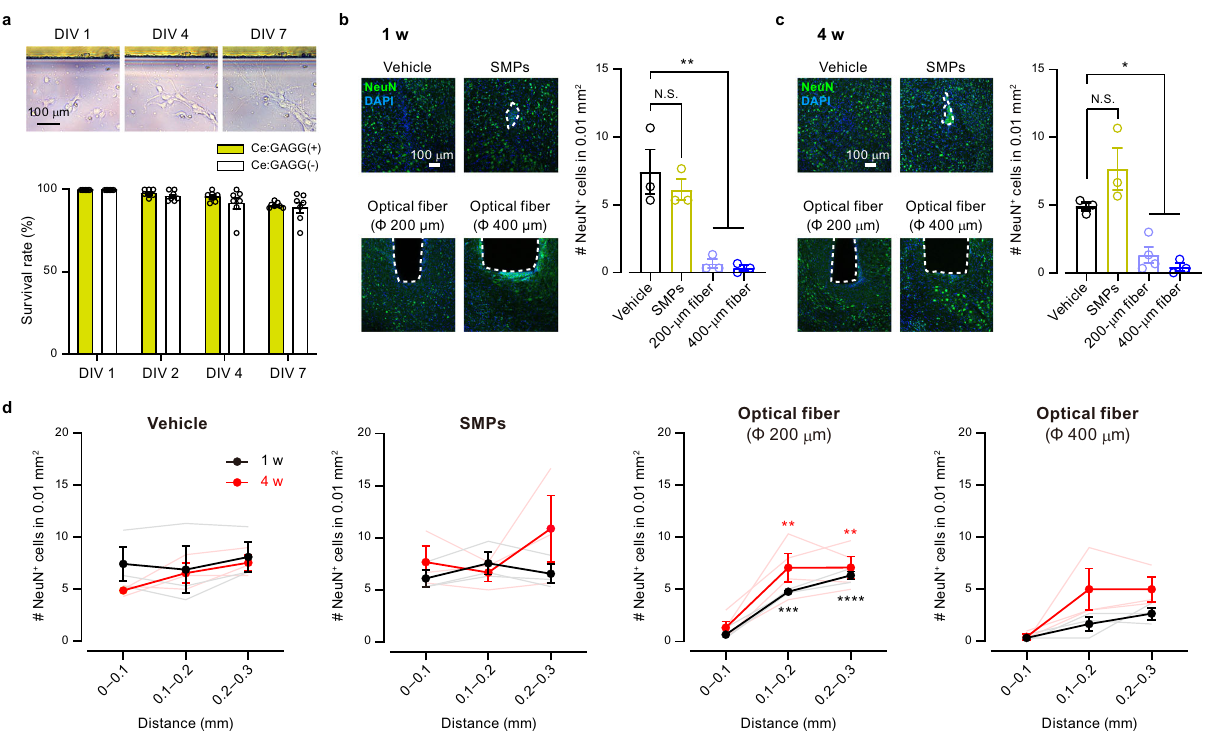
Fig. 4 Ce:GAGG microparticles were non-cytotoxic and biocompatible. a Top, dissociated hippocampal neurons cultured with a Ce:GAGG crystal (upper). Bottom, the survival rates of dissociated neurons cultured with or without a Ce:GAGG crystal ( n = 7 dishes for each group, F (1,24) = 2.18, p = 0.15; two-way ANOVA). b , c Left, representative confocal images of immunoreactivity against NeuN (green) at the injection site of vehicle or SMPs, and at the ventral tip of an implanted optical fi ber with a diameter of 200 μ m or 400 μ m, at one week (1 w) ( b ) or four weeks (4 w) ( c ) after surgery. The trace of SMPs or optical fi ber is outlined by a dashed line. Blue: DAPI. Right, an average number of NeuN-positive cells counted in a 100 μ m × 100 μ m square near the injection/implantation traces. 1 w: Vehicle, n = 3 mice; SMPs, n = 3 mice, p = 0.633, n = 3 mice, 200- μ m fi ber, n = 3 mice, ** p = 0.0022; 400- μ m fi ber, n = 3 mice, ** p = 0.0016. 4 w: Vehicle, n = 3 mice, SMPs, n = 3 mice, p = 0.106; 200- μ m fi ber, n = 4 mice, * p = 0.0277; 400- μ m fi ber, n = 3 mice, * p = 0.0121; Dunnett ’ s multiple comparison test vs. the vehicle group, two-sided. Neuronal loss was found near the optical fi ber traces, but not around implanted SMPs. d Mean number of NeuN-positive cells in a 100 μ m × 100 μ m square at different distances from the injection/implantation traces at 1 w or 4 w after surgery. 1 w: n = 3 mice for each group; 4 w: Vehicle, n = 3 mice, SMPs, n = 3 mice, 200- μ m fi ber, n = 4 mice, 400- μ m fi ber, n = 3 mice. 1 w-Vehicle, F (2,6) = 0.114, p = 0.894; SMPs, F = 0.643, p = 0.559; 200- μ m fi ber, F = 4.7, p < 0.0001; 400- μ m fi ber, F = 4.83, p = 0.0563; one-way ANOVA. 4 (2,6) (2,6) (2,6) w-Vehicle, F (2,6) = 3.34, p = 0.106; SMPs, F (2,6) = 1.11, p = 0.390; 200- μ m fi ber, F (2,9) = 9.88, p = 0.0054; 400- μ m fi ber, F (2,6) = 3.80, p = 0.0857; one- way ANOVA. 200- μ m fi ber: 1 w, 0.1 – 0.2 mm, *** p = 0.0001; 1 w, 0.2 – 0.3 mm, **** p < 0.0001; 4 w, 0.1 – 0.2 mm, ** p = 0.0072; 4w, 0.2 – 0.3 mm, ** p = 0.0072; Dunnett ’ s multiple comparison test vs. the 0 – 0.1 mm group, two-sided. Open circles and lightly colored lines indicate individual data. N.S., not signi fi cant. Values are mean ±